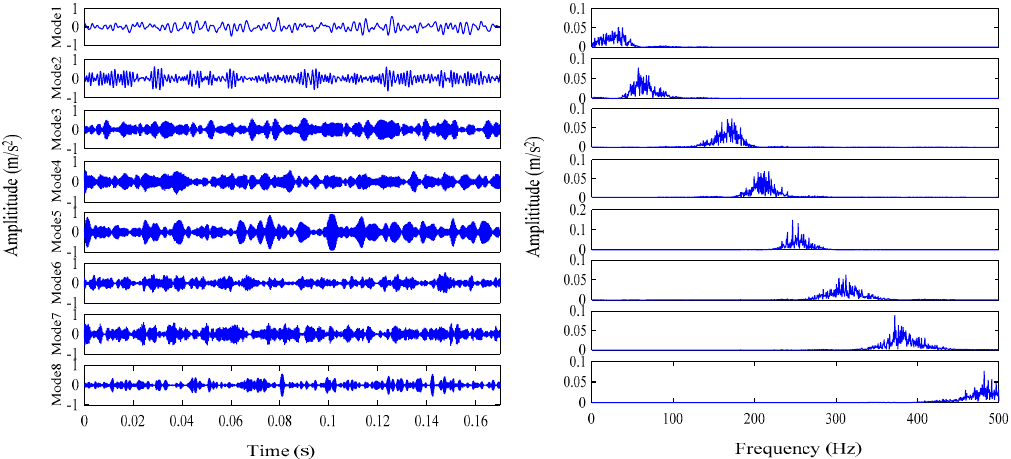
Figure 8. Decomposition results and corresponding frequency spectrum of modes by using improved variational mode decomposition (IVMD).